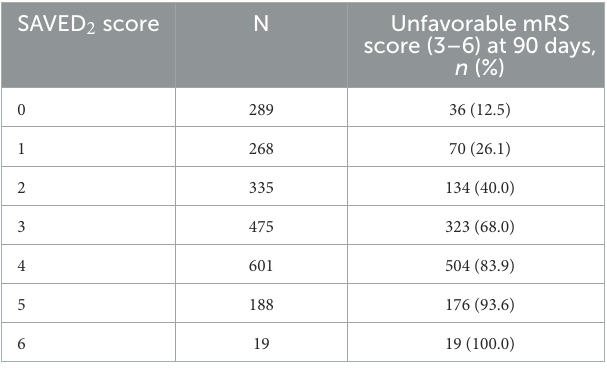
TABLE 5 Distribution of SAVED 2 scores in derivation cohort from ERICH.